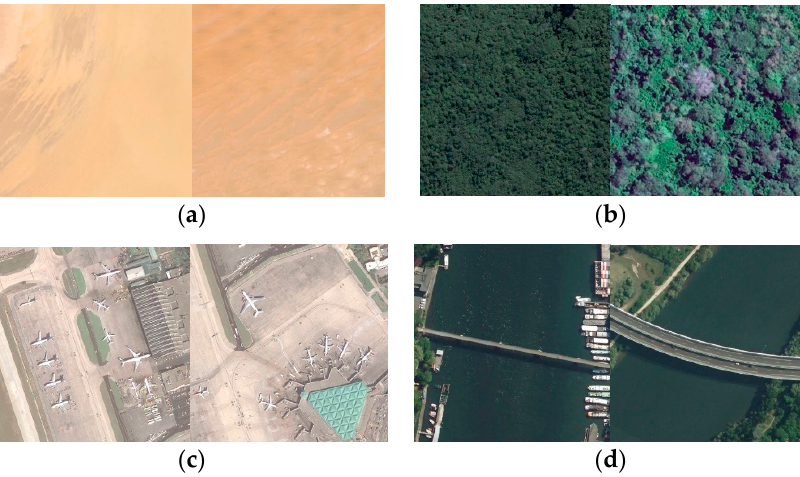
Figure 1. Some samples images from Aerial Image Data (AID). ( a ) desert, ( b ) forest, ( c ) airport, ( d )